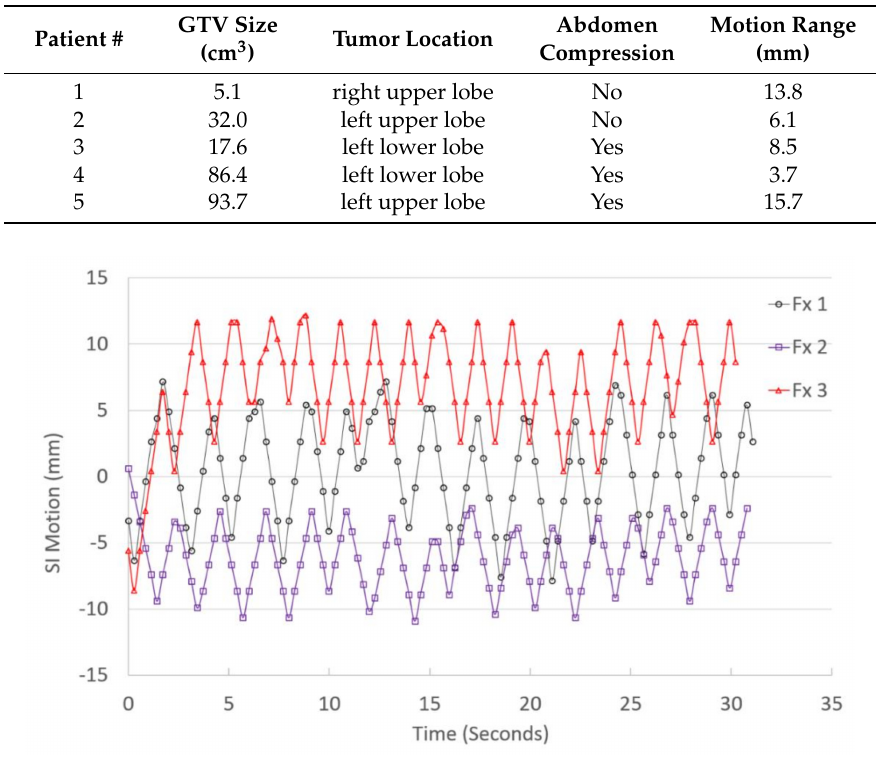
Figure 5. Lung tumor trajectories detected in the SI positions at a gantry angle of 270 ◦ for Patient #5 during three fractions/days (Fx 1, Fx 2, and Fx 3) of the treatment